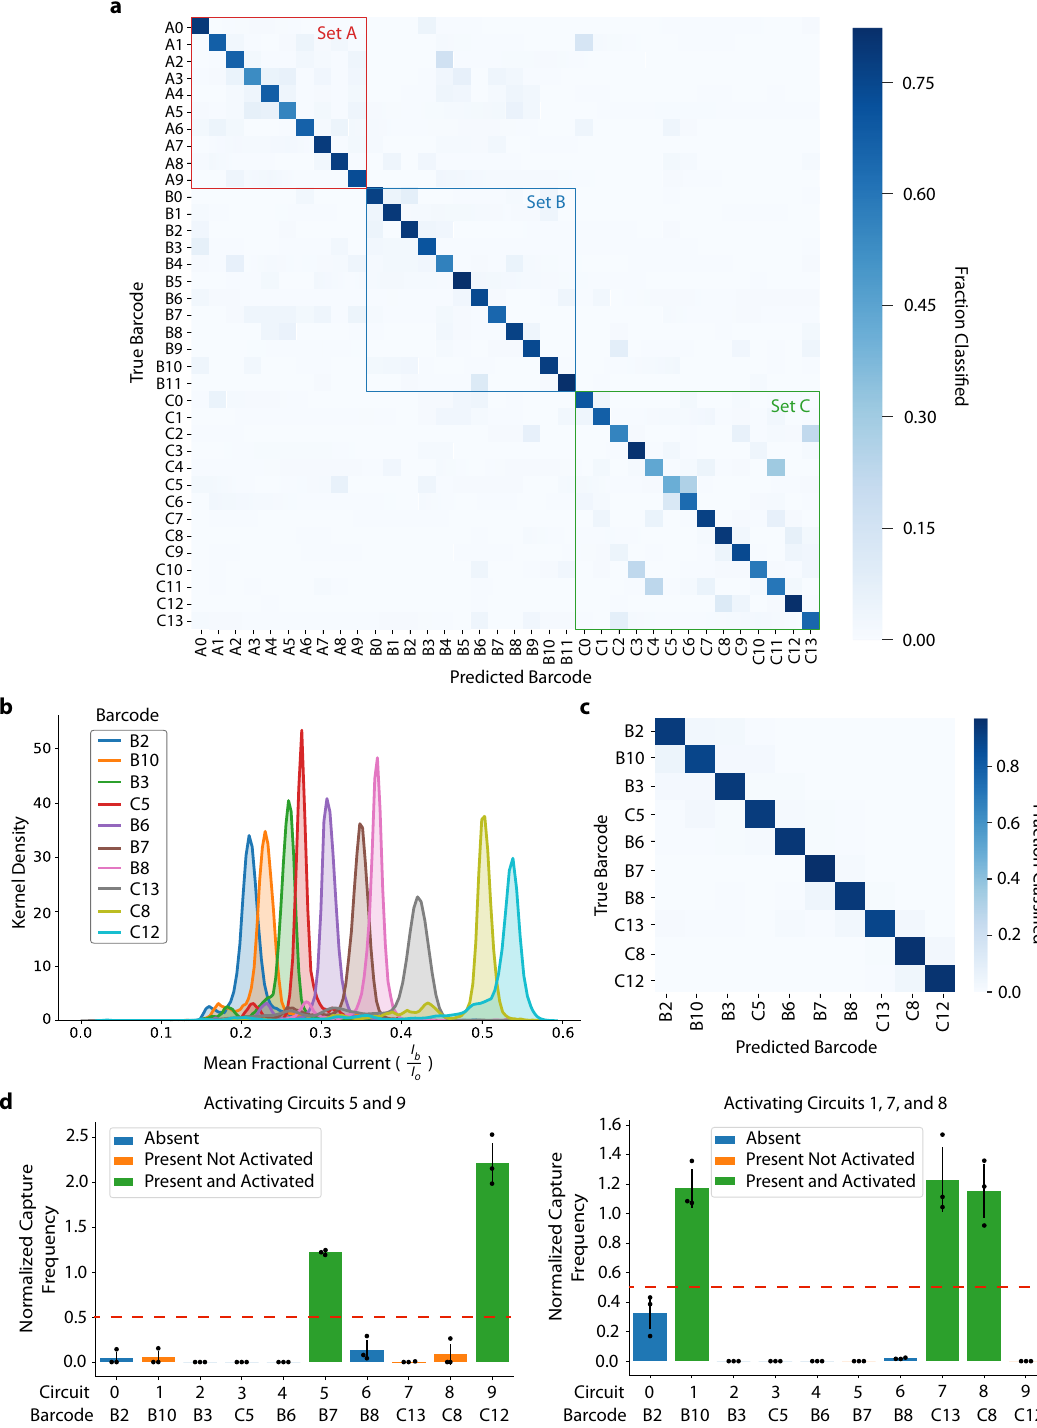
Fig. 4 | Developing an optimized nanopore barcode set. a Confusion matrix showing results of ResNet-18 CNN trained on all 36 characterized barcodes. CNN achieved an accuracy of ~67% on the test set. b Density plot showing the dis- tribution of mean fractional current for each barcode selected for the highly separable set. Each distribution is composed of ~13000 data points. c Confusion matrix showing results of ResNet-18 CNN trained only on the selected highly separablebarcodes,whichachievedanaccuracyof93%onthetestset. d Barplots